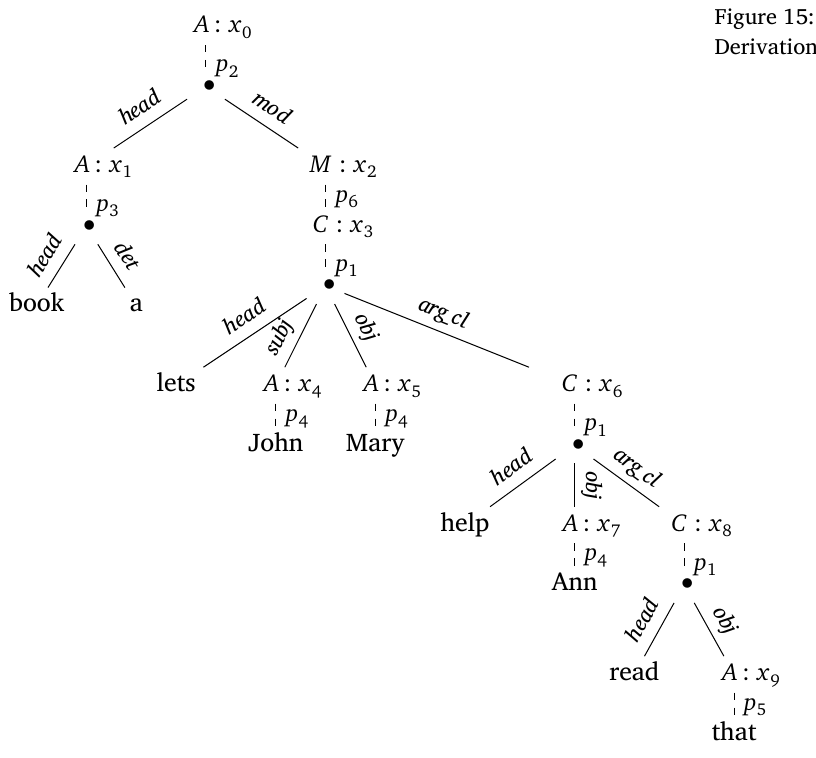
Figure 15: Derivation tree of